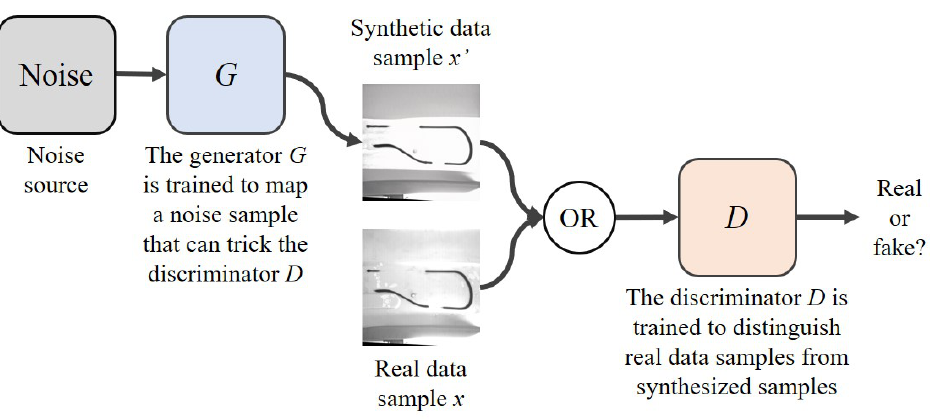
Figure 2. Basic structure of a Generative Adversarial Network (GAN). The generator G and discrim- inator D are generally implemented by multi-layer networks consisting of convolutional and/or fully-connected layers. Adapted from